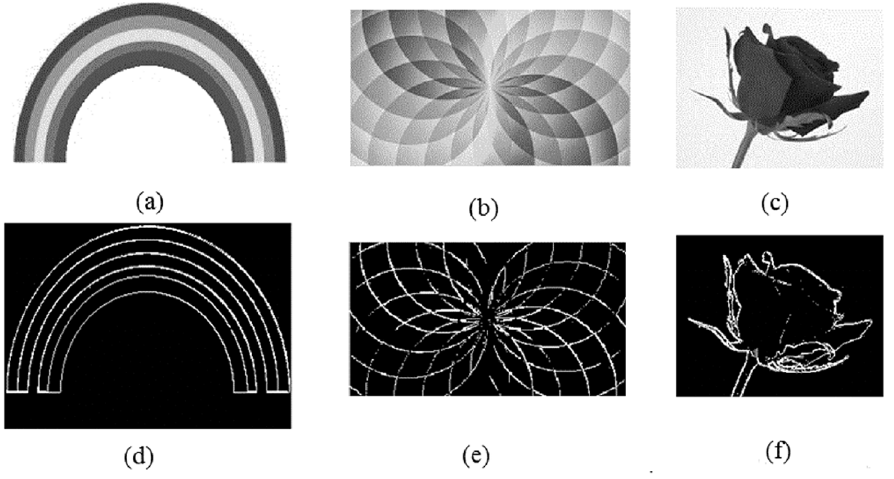
Fig 8. Tested images: (a) Rainbow, (b) Flower, (c) Flower 1, (d) Edge detection in rainbow image, (e) flower image and (f) flower 1 image.